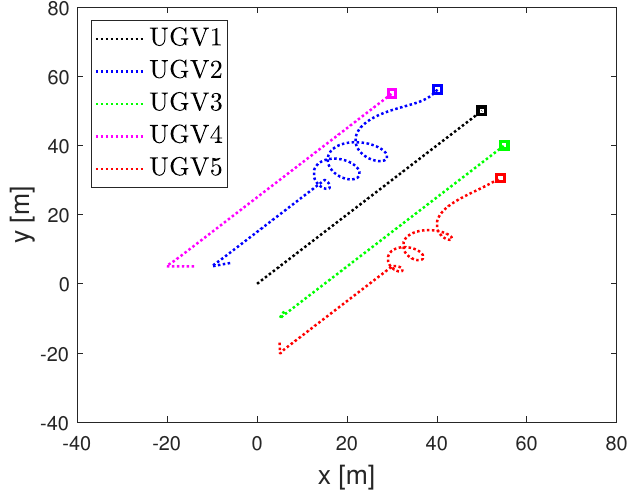
Figure 9. Swarm operation of